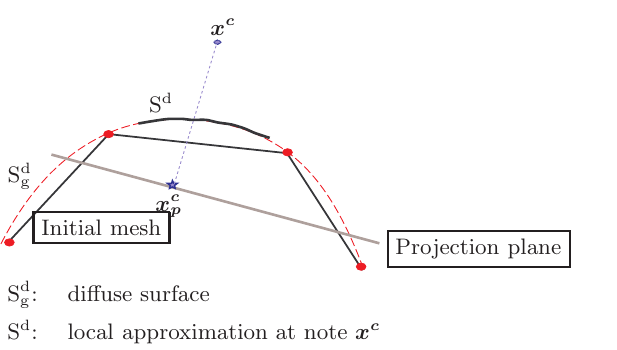
Fig. 6. Local or global approximation?